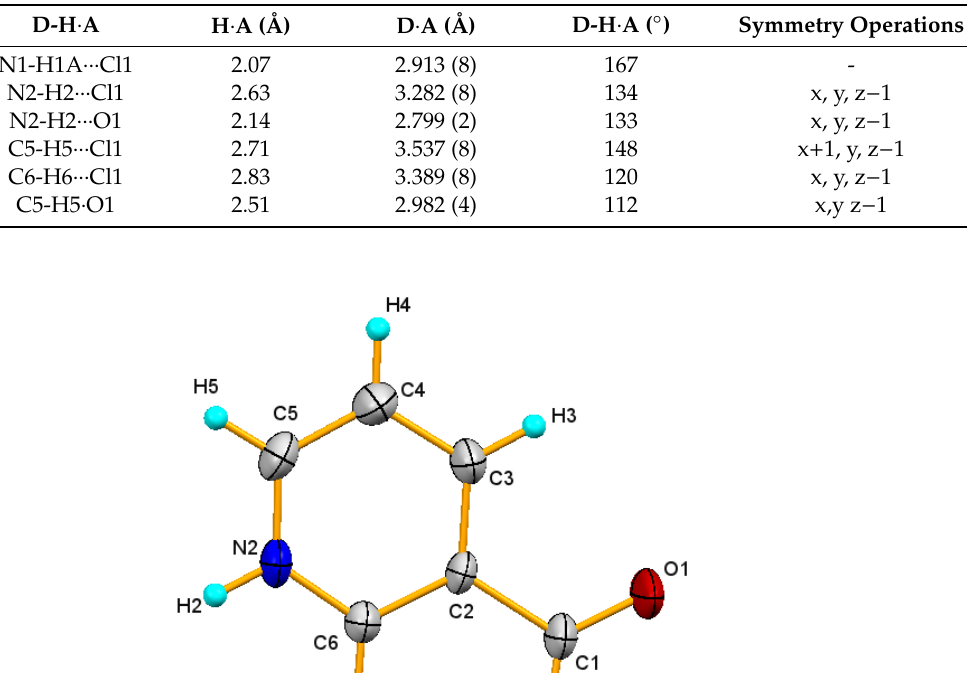
Figure 3. A view along [010] showing organic cations linked by chloride anions via N–H···O (Red), N–H···Cl and C–H···Cl (Green) hydrogen bonds shown as dashed lines. 3.2. Crystal Morphology and Packing The morphology of (C 6 H 7 N 2 O) + ·Cl − molecule was predicted using the Materials Studio program [23]. BFDH method is based on geometrical calculations of unit cell dimensions and symmetry operators to define a list of potential growth faces and their eagerness to grow. The aims of BFDH